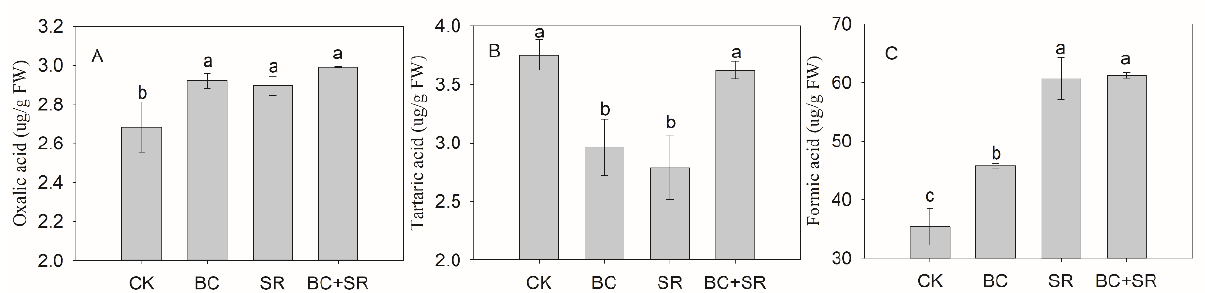
Figure 6. Effect of different soil types on soil oxalic acid ( A ), tartaric acid ( B ), and formic acid ( C ). CK, sand only; BC, biochar; SR, sand and soft rock; BC + SR, sand, biochar, and soft rock. Data are shown in mean ± SD. Different letters indicate significant differences ( p < 0.05).